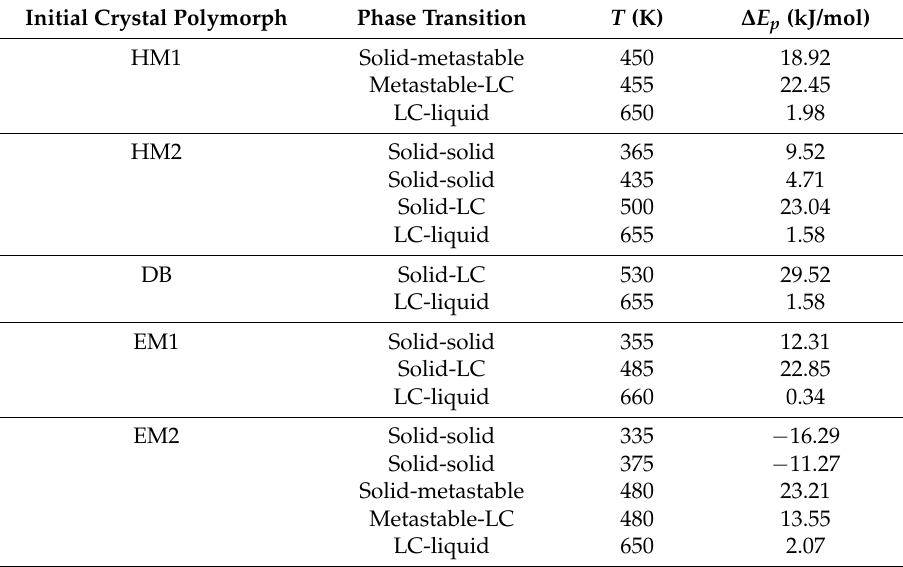
Figure 4. Caloric curve of one mole [C 14 Mim][NO 3 ] in each system during heating. Table 2. Phase transition temperatures and potential energy changes. Table 2. Phase transition temperatures and potential energy changes.